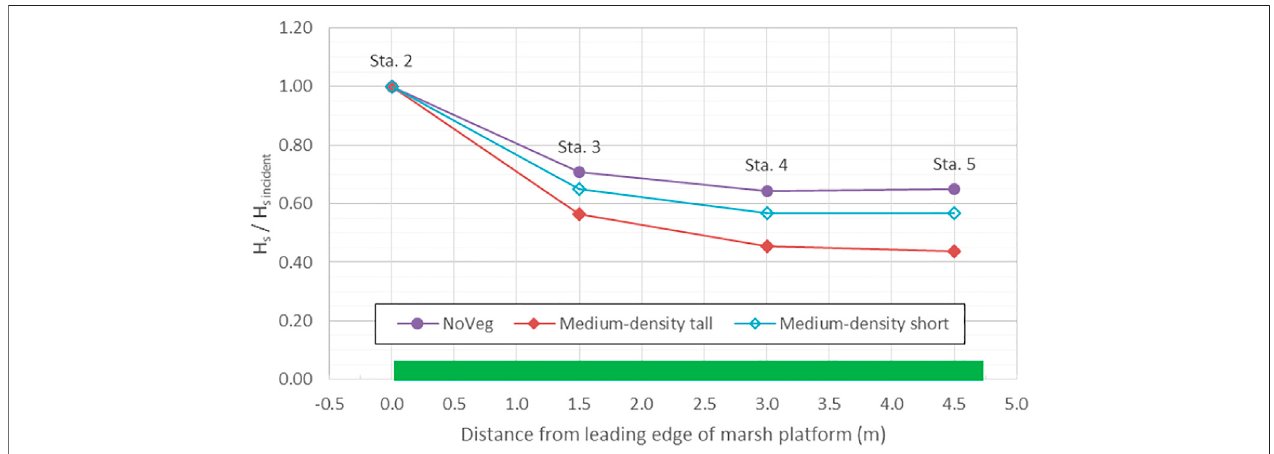
FIGURE 13 | Wave attenuation across similar arti fi cial marshes featuring different vegetation heights. Data is normalized by the incident wave height at the edge of the marsh (@ Station 2). Note that this fi gure includes the effect of wave transformation and breaking due to the sloping foreshore.